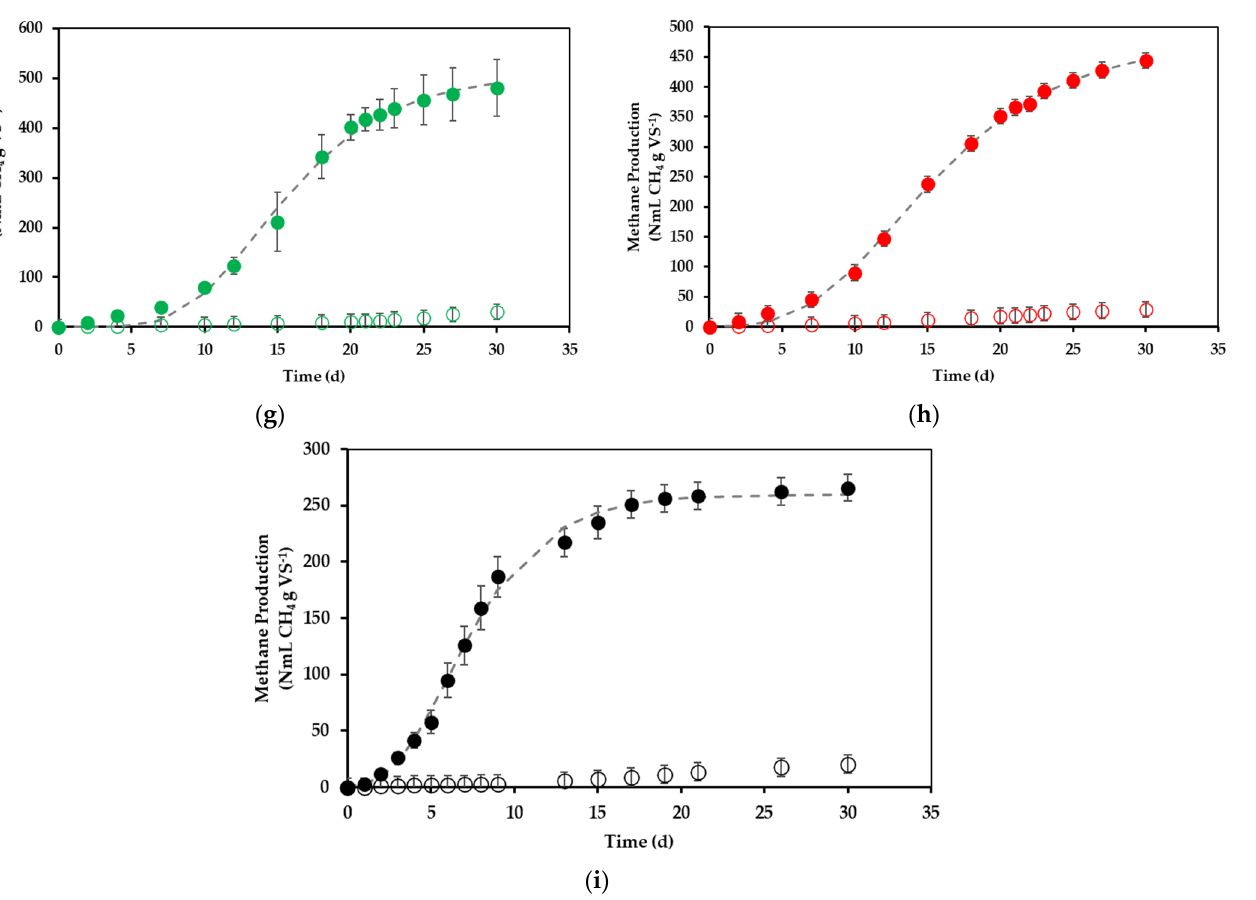
Figure 3. Behavior of the methane production during the incubation time for each of the conditions tested in the 2 3 factorial design (average value ± SD): ( ● ) samples of the raw olive alperujo; ( ◦ ) control assay; (---) adjusted Gompertz model. Assays: ( a ) 1, ( b ) 2, ( c ) 3, ( d ) 4, ( e ) 5, ( f ) 6, ( g ) 7, ( h ) 8 and ( i ) central point. Table 5. Results corresponding to the experimental conditions and the Gompertz model for a 2 3 factorial design (experimental: average value ± SD; model: value obtained from the solver tool).